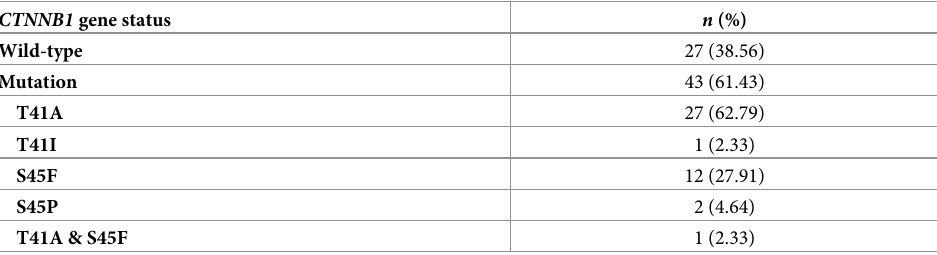
Table 4. Mutation types of the CTNNB1